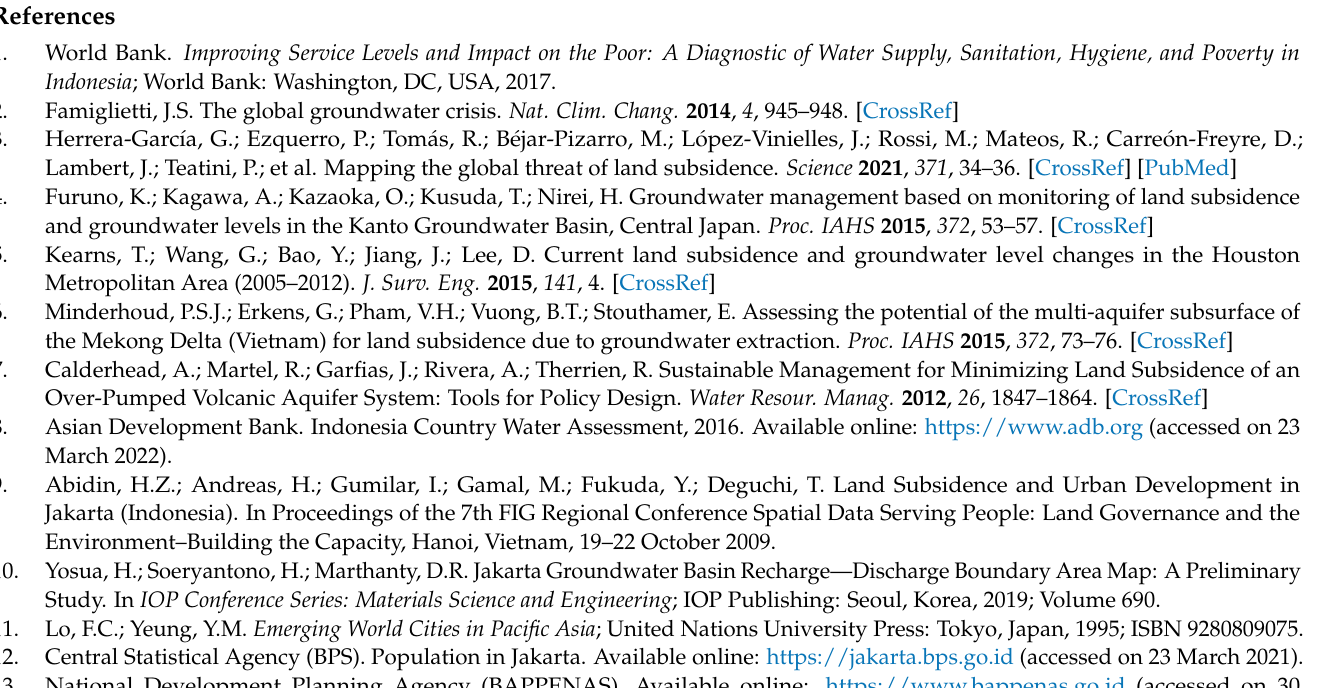
Figure A1. Raster map of groundwater levels above the mean sea level of Jakarta Bay plotted with the altitude contours in the Jakarta region.